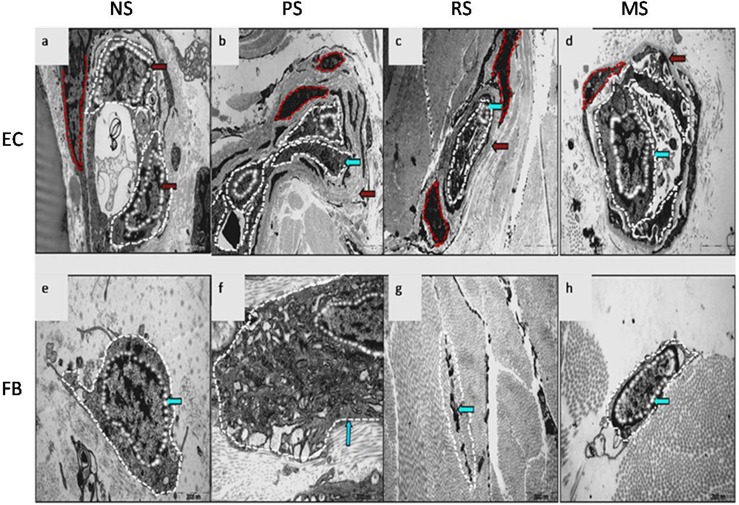
Electron microscopy examination of human hypertrophic scars at different stages.Morphological changes in the microvessels and ECs in NS (a, ×9,700), PS (b, ×4,200), RS (c, ×5,800) and MS samples (d, ×13,500) are shown. The blue arrow indicates ECs and the red arrow indicates the basement membrane. The white dotted line shows ECs, and the red dotted line shows smooth muscle cells. Morphological changes in the fibroblasts in NS (e, ×13,500), PS (f, ×17,500), RS (g, ×13,500) and MS samples (h, ×13,500) are shown. The blue arrow indicates fibroblasts.